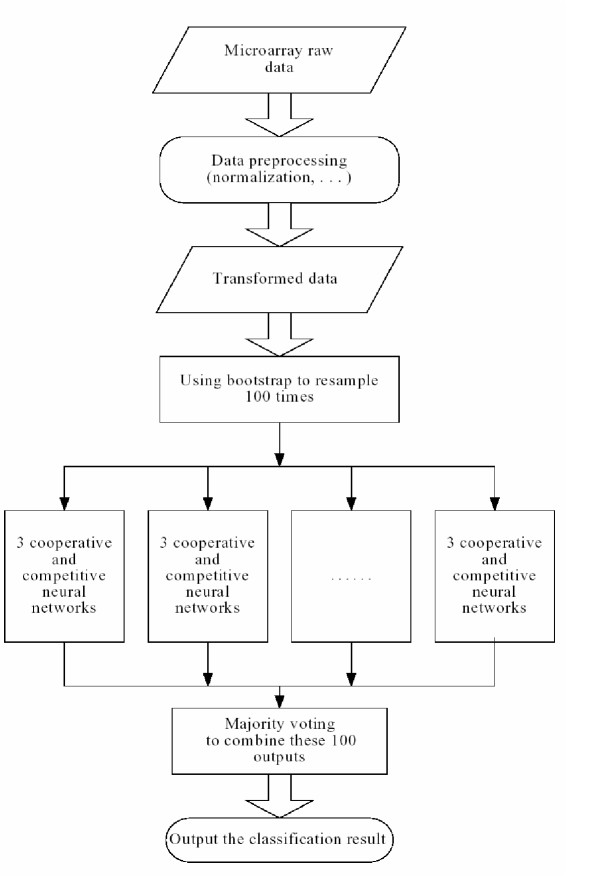
The whole flow chart